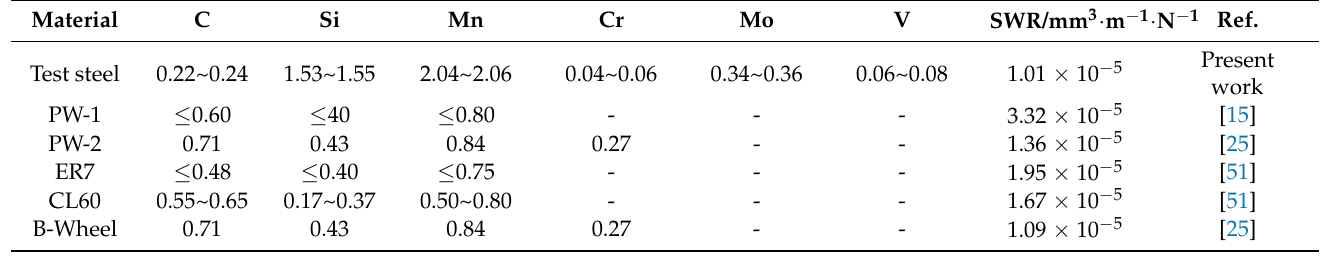
Figure 11. ( a ) The thickness of GS layer ( T GS ) and ( b ) the hardening rate along with the running speeds. Table 5. SWR data and chemical composition (wt%) of wear-resistant materials for railway reported under rolling–sliding wear.